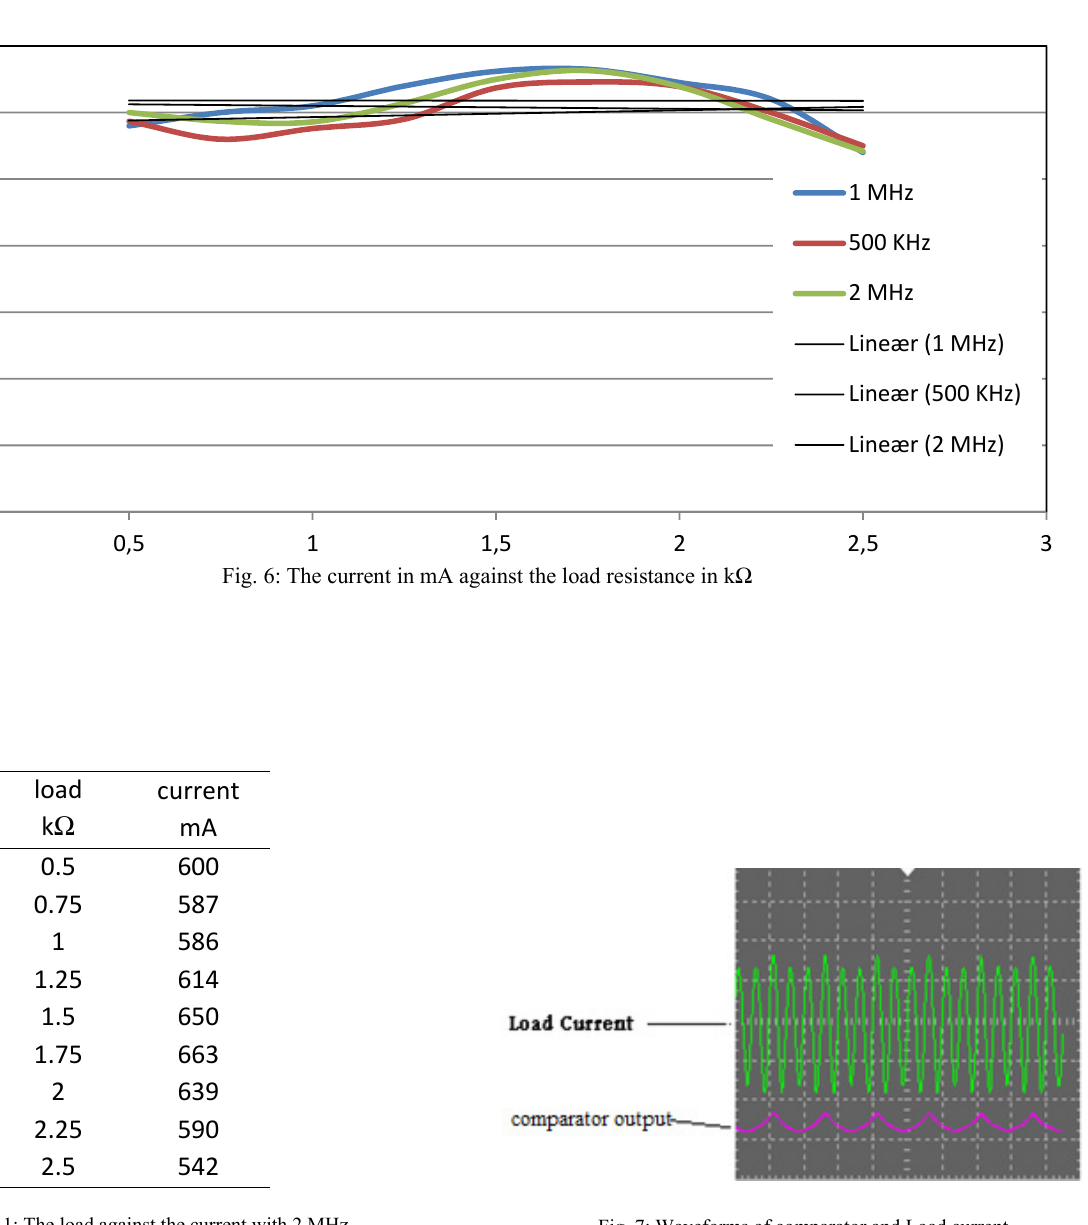
Table 1: The load against the current with 2 MHz Fig. 7: Waveforms of comparator and Load